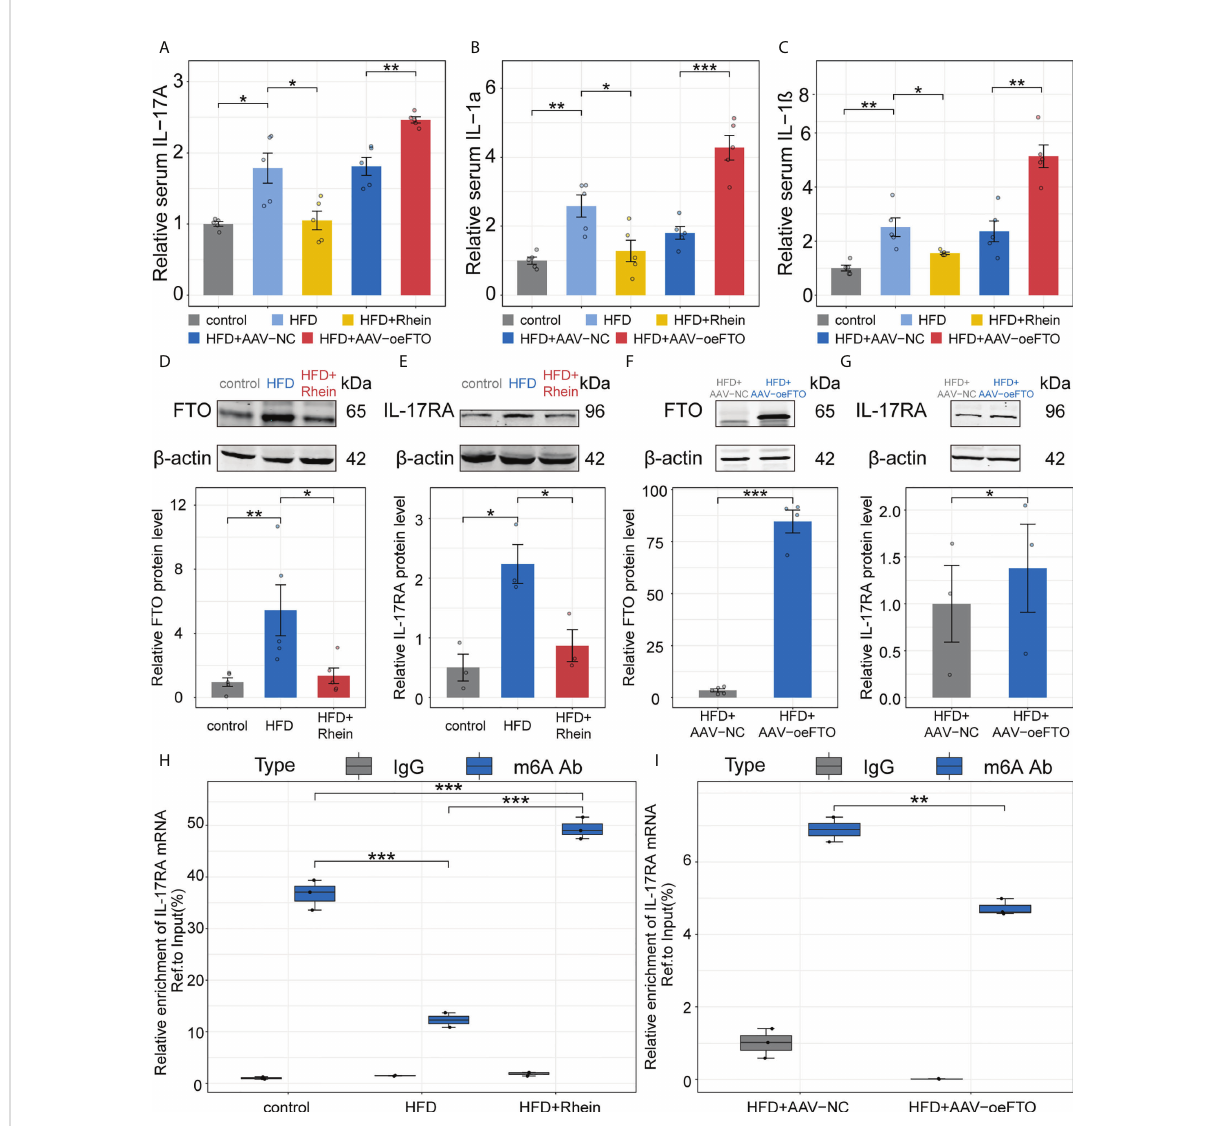
FIGURE 5 FTO facilitates liver in fl ammation via induction of IL-17RA in murine NAFLD model. (A-C) . Relative serum IL-17A, IL-1 a , and IL-1 b in all groups with different treatment. (D, E) . Relative FTO, and IL-17RA protein level in the control, HFD, and HFD + Rhein groups. (F, G) . Relative FTO, and IL-17RA protein level in the HFD + AAV-NC, and HFD + AAV-oeFTO groups. (H, I) . Relative m6A enrichment of IL-17RA mRNA in liver tissues of different groups by m6A-RIP-qPCR. All experiments were repeated at least three times and expressed as the means ± SEM. n = 5; * p < 0.05; ** p < 0.01; *** p <